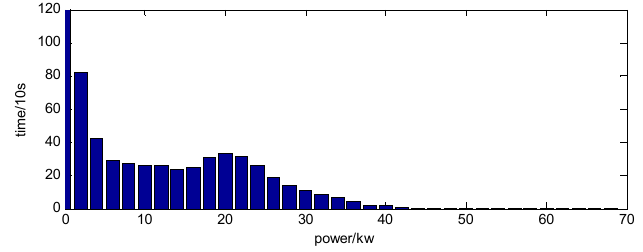
Figure 9. Operating time distribution of ESS in different discharge power.